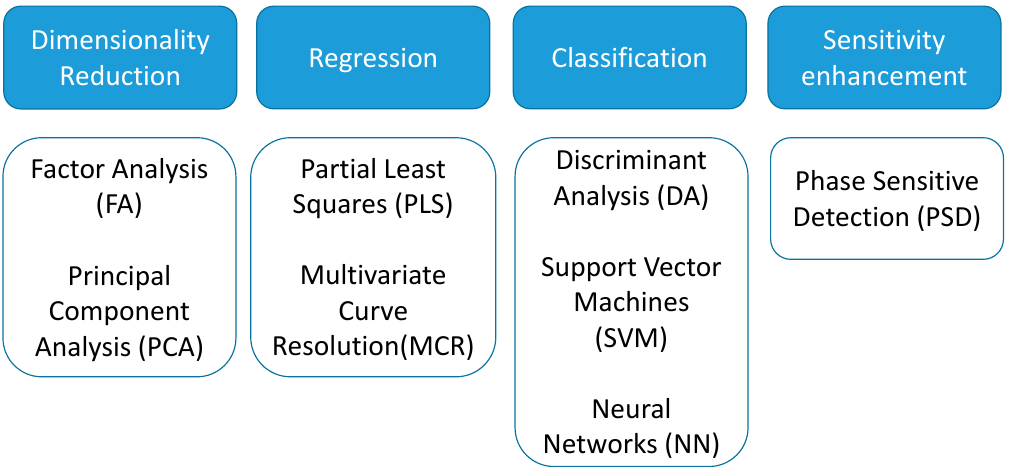
Figure 1. Schematic view showing main multivariate methods grouped according to their field of application.